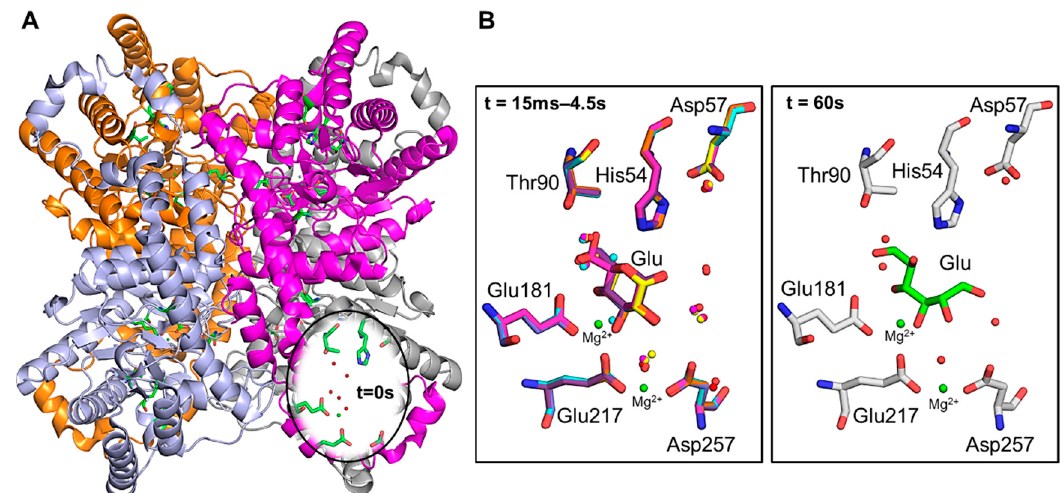
Figure 3. TR-SSX for xylose isomerase with LAMA system. ( A ) Cartoon representation of the tetramer structure of xylose isomerase. The key residues at the catalytic site are highlighted as green sticks. The black circle shows a closer view of the key residues in the resting state (t = 0 s). ( B ) Close-up views of the xylose isomerase active site shown at different time points upon mixing. Left panel shows the superimposition of xylose isomerase structures between t = 15 ms and t = 4.5 ms in complex with glucose in closed ring conformation. Right panel shows the structure of xylose isomerase at t = 60 s with the glucose in open ring conformation. The active site residues and the glucose molecules are shown as sticks, waters as red spheres and magnesium as green spheres.